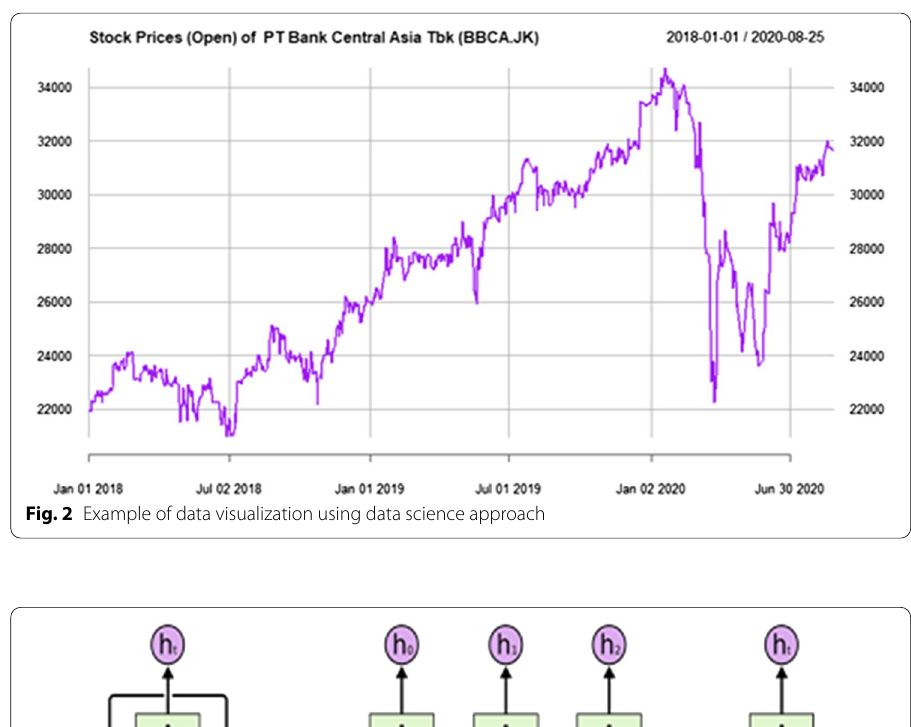
Fig. 3 The basic model of Recurrent neural networks (RNN)